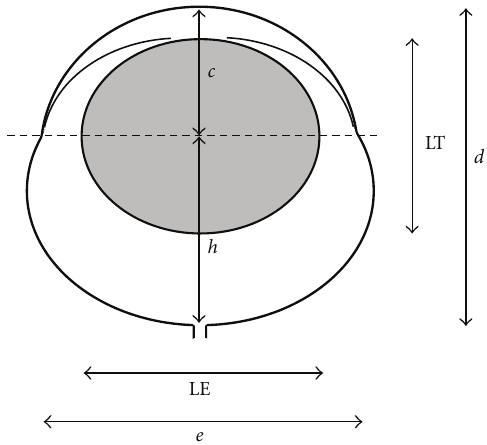
Figure 1: Schematic diagram showing the ocular dimensions obtained from the MRI. d: axial length; c: anterior segment length; h: posterior segment length; e: equatorial diameter at the plane of the ora serrata ( dashed line ); LT: lens axial thickness; LE: lens equatorial